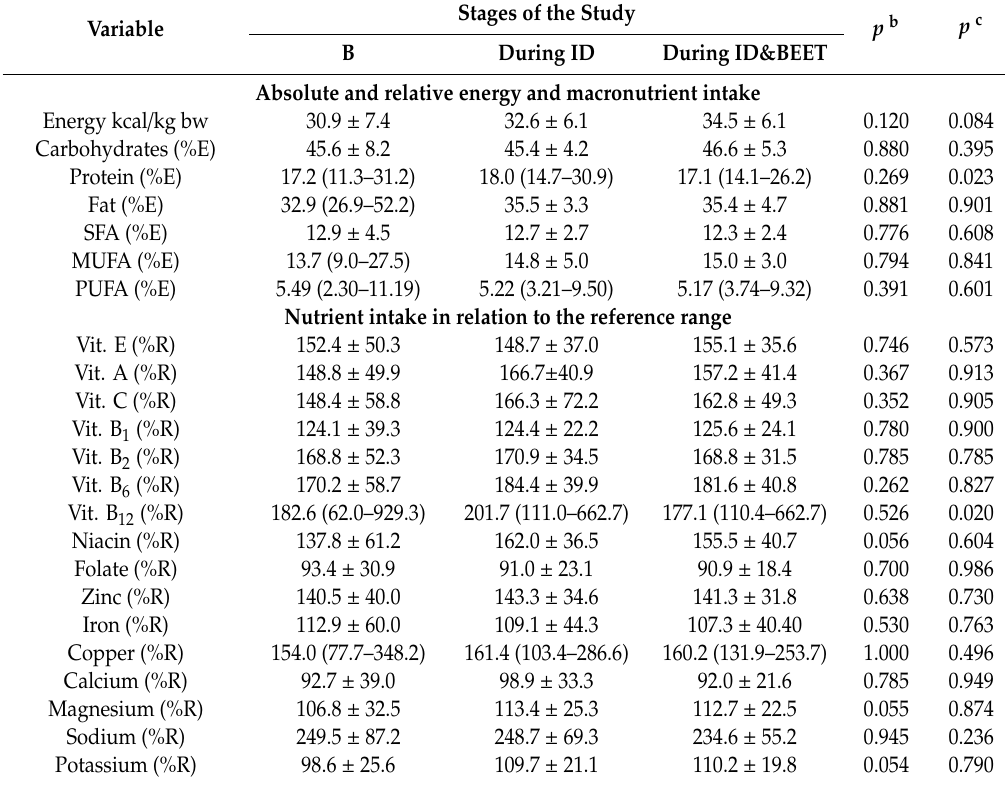
Table 2. Absolute and relative energy and macronutrient intake as well as selected nutrient intake in relation to the reference range calculated from a three-day dietary records at the studied group of fencers (n = 20) a